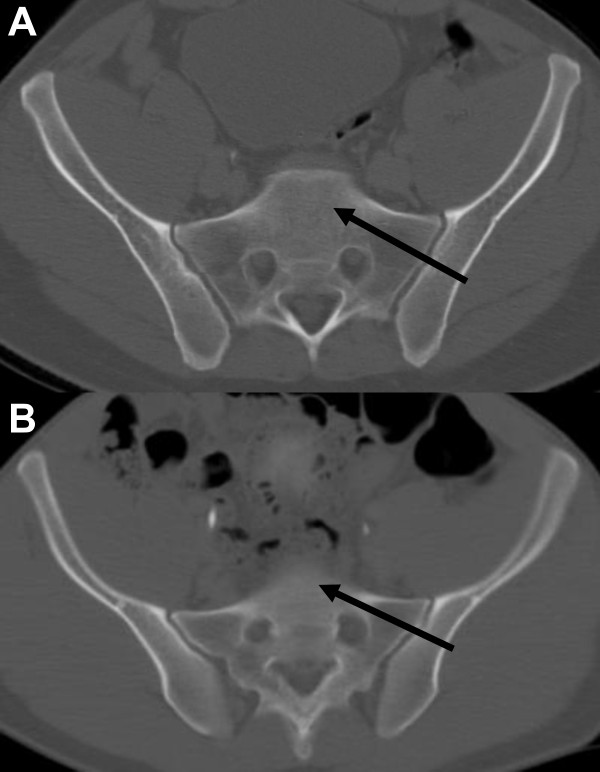
Example of a "safe surgical corridor" for SI-screw trajectories in a normal (panel A) and dysmorphic sacrum (panel B). Based on the vestibular concept described by Carlson et al. [29], the entry point was placed perpendicular to the narrowest point at the level of the sacral foramen, the so-called "vestibule". See text for details and explanations.